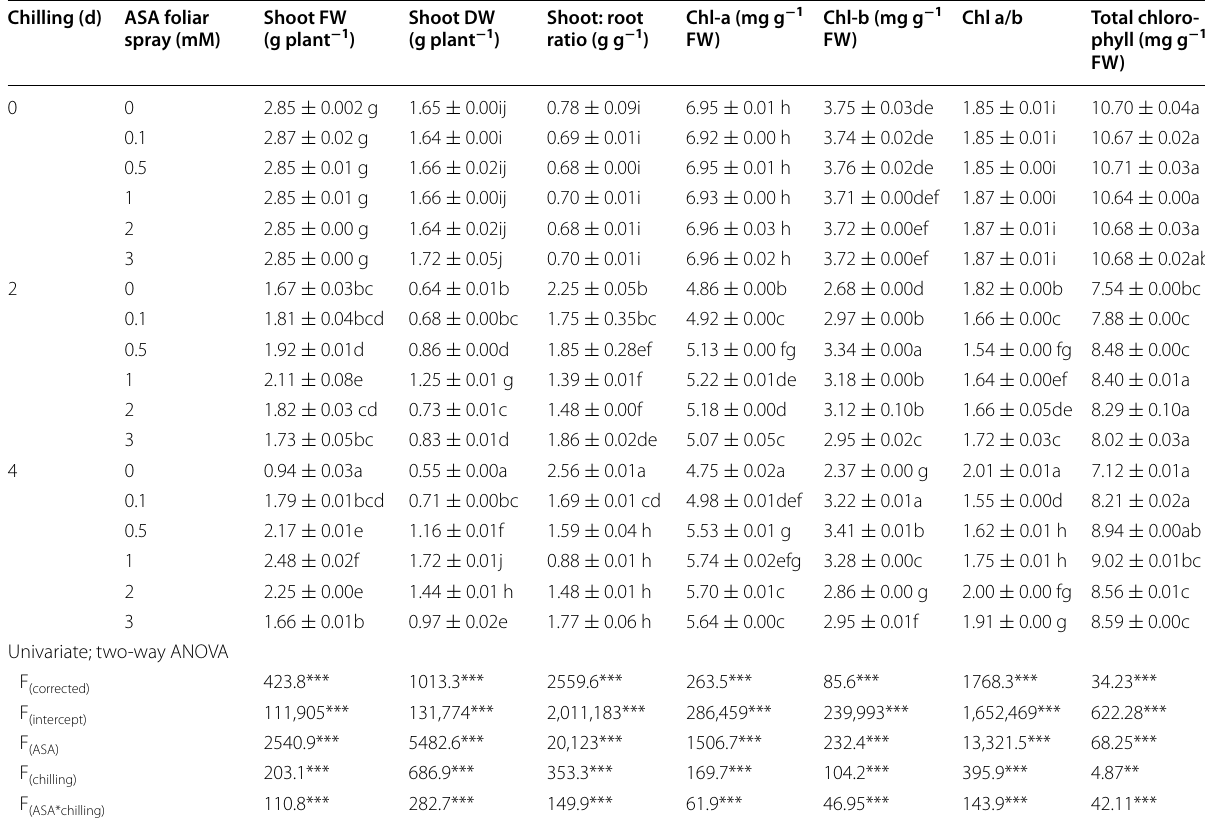
Table 2 Shoot fresh weight (g plant − 1 ), dry weight (g plant − 1 ), shoot: root ratio (g g − 1 ), chlorophyll-a (mg g − 1